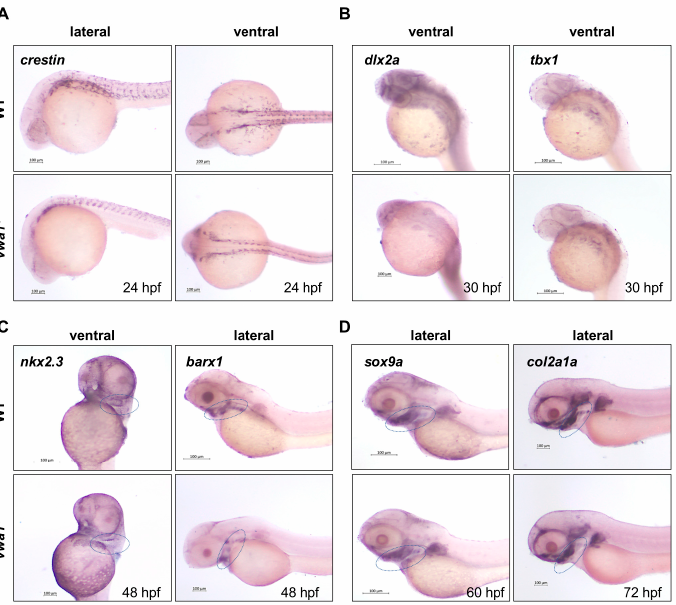
Figure 4. vwa1 functions in cranial neural crest cell condensation. ( A ) WISH analysis of crestin at 24 hpf showed no significant difference between vwa1 mutants and WT controls. ( B ) The expression pattern of dlx2a and tbx1 were essentially normal in the pharyngeal arch at 30 hpf, although the absolute area was smaller owing to the reduced body size of mutants. ( C ) At 48 hpf, expression of the endodermal pouch marker, nkx2.3 , was not significantly different between mutant embryos and WT controls. However, the expression of barx1 , indicative of the condensation of prechondral mes- enchymal cells, was significantly reduced in the pharyngeal region of vwa1 mutants compared with that in WT controls. ( D ) Expression level of sox9a did not change significantly at 60 hpf, whereas the expression of col2a1a decreased at 72 hpf. The mandibular region is marked with dotted blue circles.